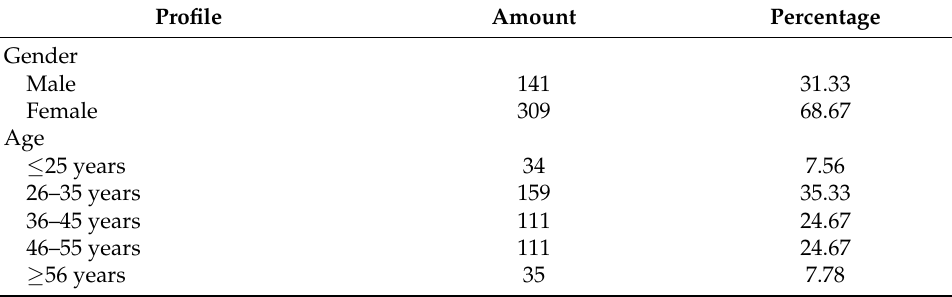
Table 1. Profile of the research